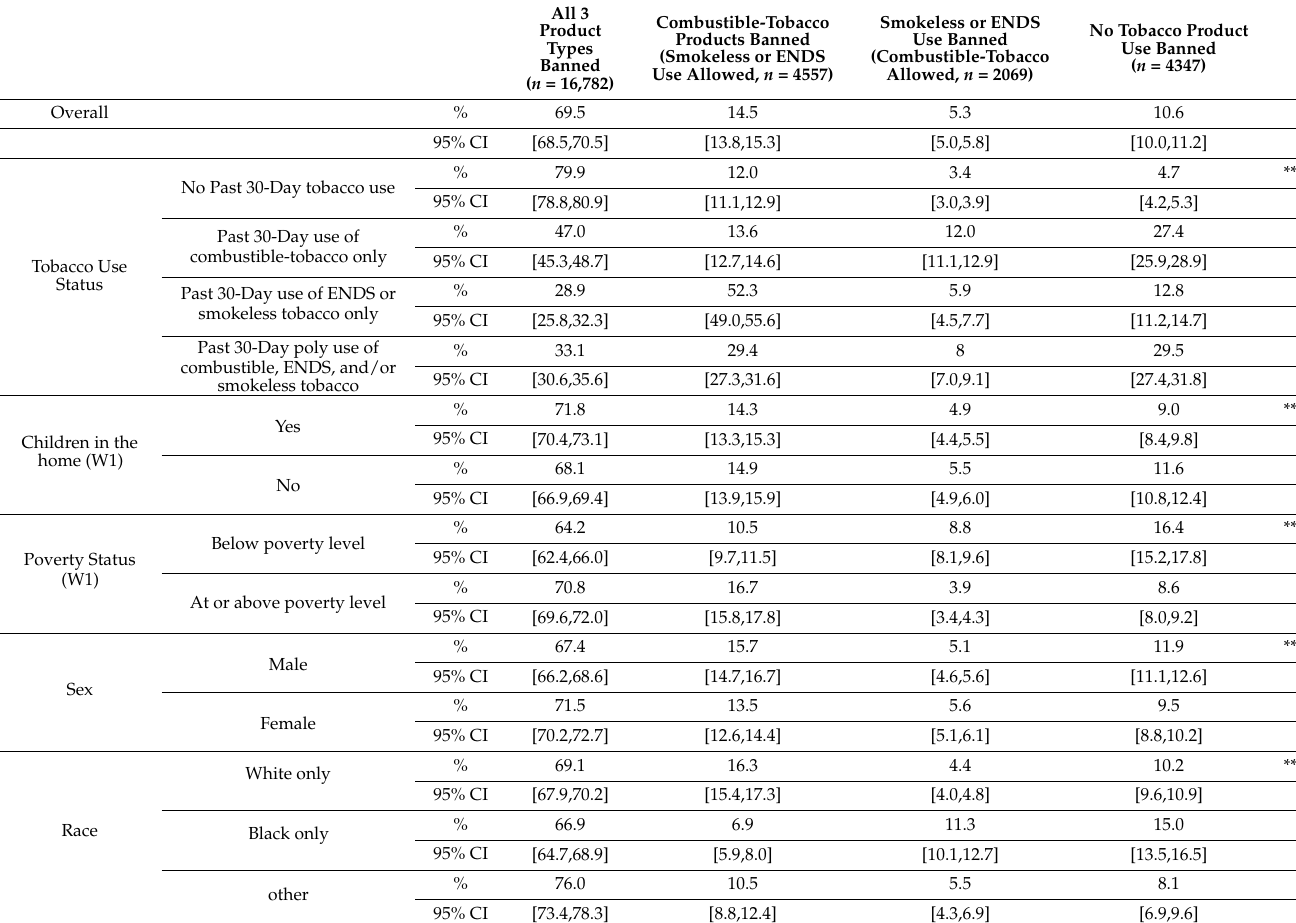
Table 1. Characteristics of adults with home tobacco use bans, PATH Study Wave 4: 2016–2018 ( n =